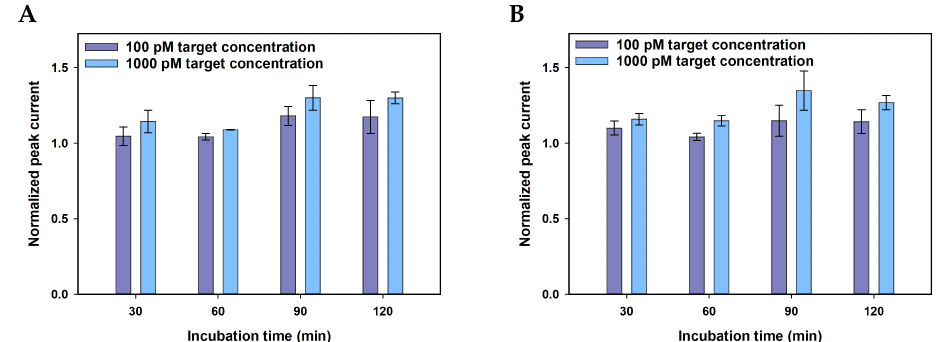
Figure A5. Detection of 100 (purple) and 1000 (blue) pM of the target gene of the target gene with various antigen incubation times (30, 60, 90 and 120 min) using both CV ( A ) and DPV ( B ) techniques.